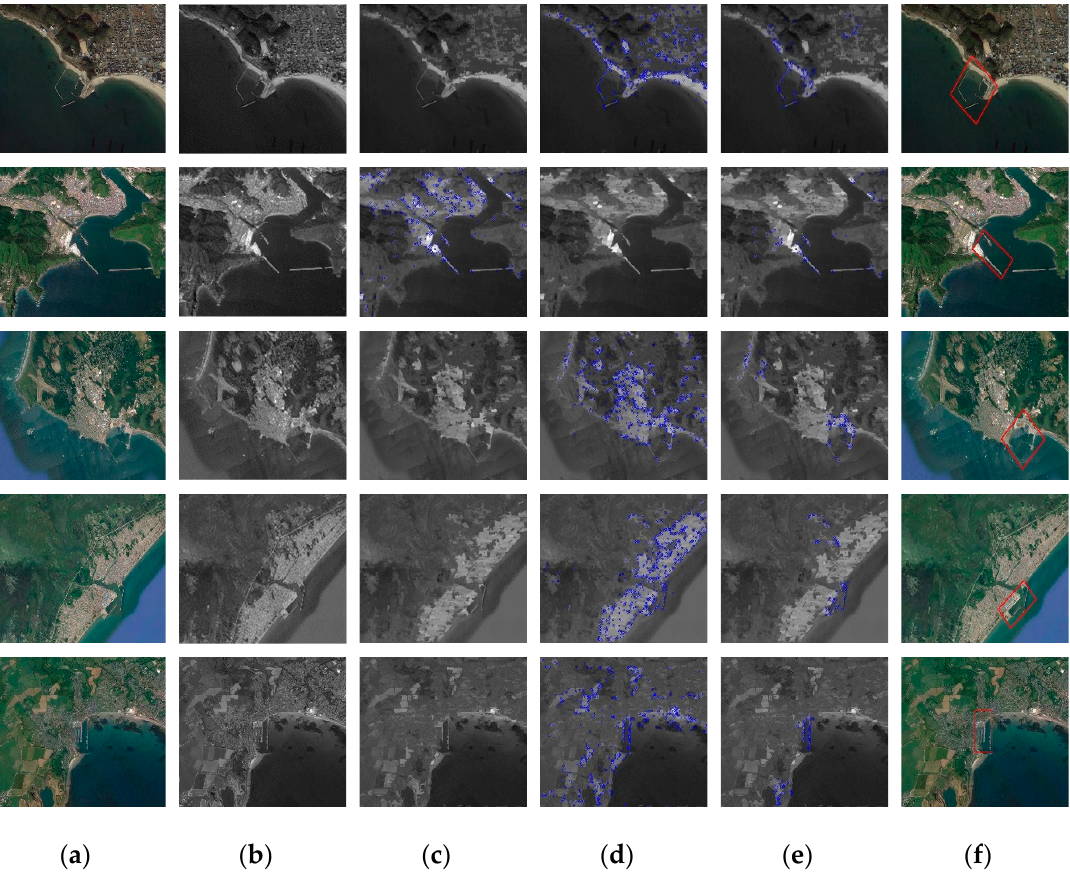
Figure 7. ( a ) Original image. ( b ) Extracting image luminance channel. ( c ) Processing results of LEPA algorithm. ( d ) Processing results of EC-SIFT algorithm. ( e ) Harbor candidate region extraction results. ( f ) Harbor target extraction results.